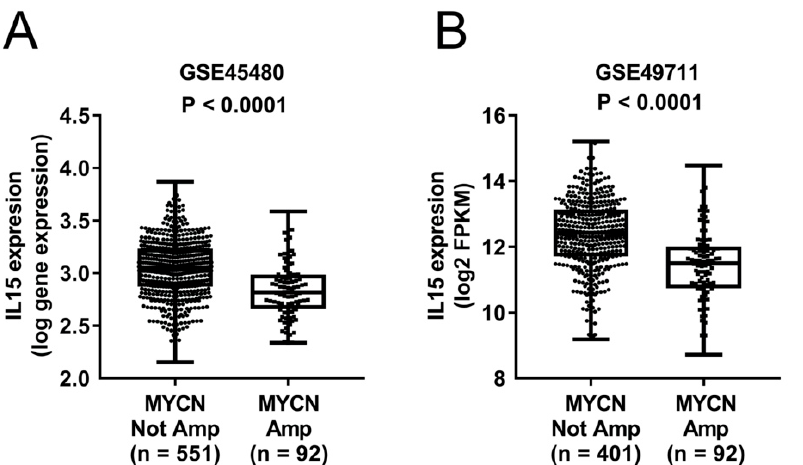
Figure 1. Higher expression of IL-15 in MYCN-non-amplified than MYCN-amplified NBL. IL-15 RNA expression levels were shown as boxplots of log gene expression in GSE45480 ( A ) and log2 fragments per kilobase of exon per million fragments mapped (FPKM) expression in GES49711 ( B ). t -test was applied for statistical comparison.